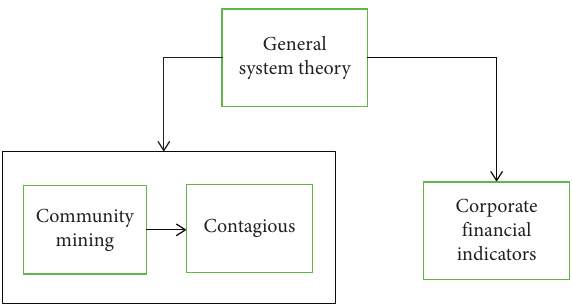
Figure 2: General system theory construction.